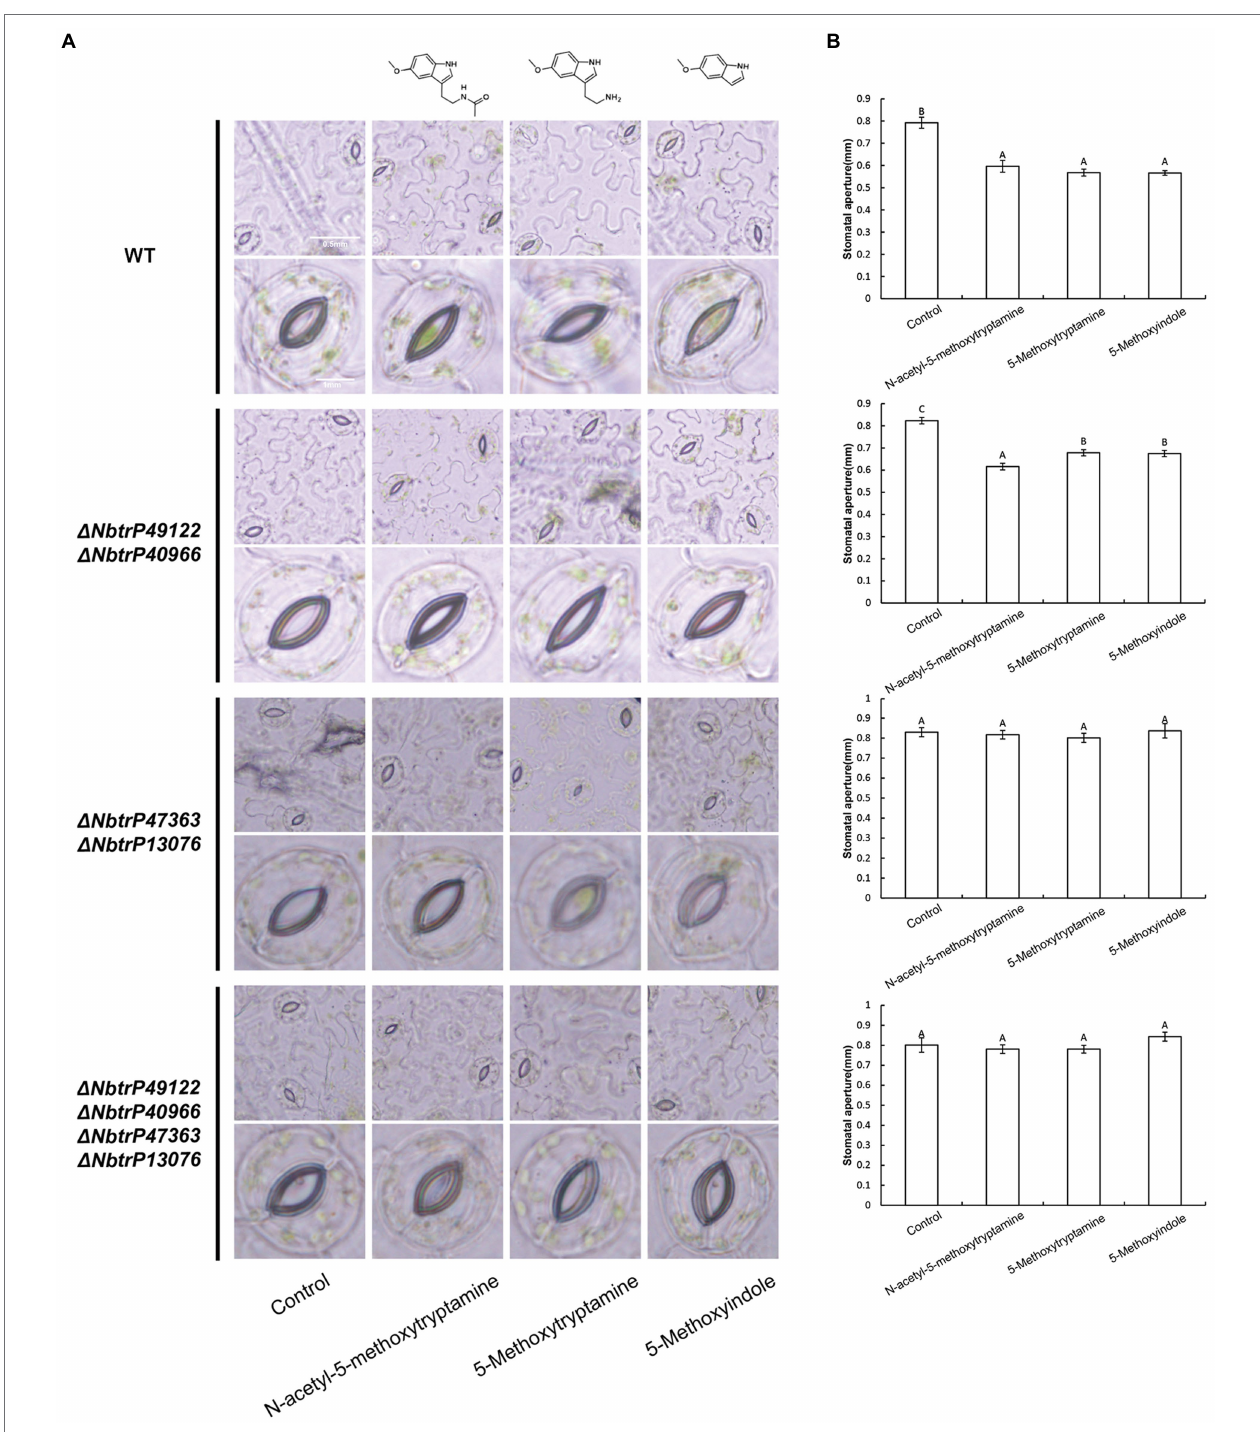
FIGURE 8 | Melatonin, 5-methoxytryptamin, and 5-methoxyindole induce stomatal closure in N. benthamiana leaves involve the transmembrane receptors trP47363 and trP13076. MT-, 5-methoxytryptamin-, and 5-methoxyindole-induced stomatal closure in leaves of VIGS mutants of N. benthamiana revealing the role of the transmembrane receptors, trP47363 and trP13076. Two-week-old N. benthamiana plants were infiltrated with a mixture of A. tumefaciens Gv3101 strains carrying pTRV1 or pTRV2 constructs as described in the Materials and Methods. Five weeks later, plants were watered with 0.005% (v/v) ethanol/water (control) or 50 μ M solutions of MT, 5-methoxytryptamine, or 5-methoxyindole. Stomata were observed under a microscope 3 h after the application of the treatment solutions. (A) Representative low- and high-magnification images. (B) Measurements of stomatal aperture. Data are the mean ± standard deviation (SD; n = 150). Columns with different letters indicate significant differences between the different treatment groups in the different VIGS lines as determined by a Duncan’s multiple range